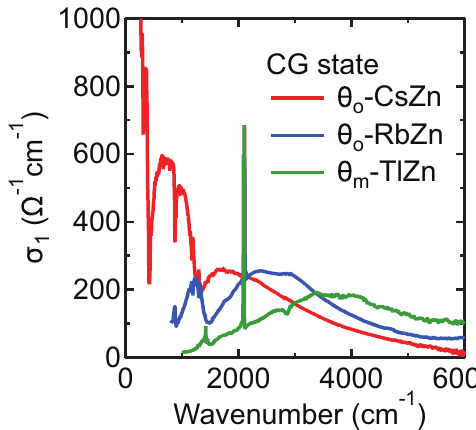
Figure 4. Comparison of optical conductivity spectra of the charge–glass states in the θ –type salts. Optical conductivity spectra of the charge-glass states in θ o -CsZn (red), θ o -RbZn (blue), and θ m -TlZn (green) measured at 4K, 50K, and 50K,